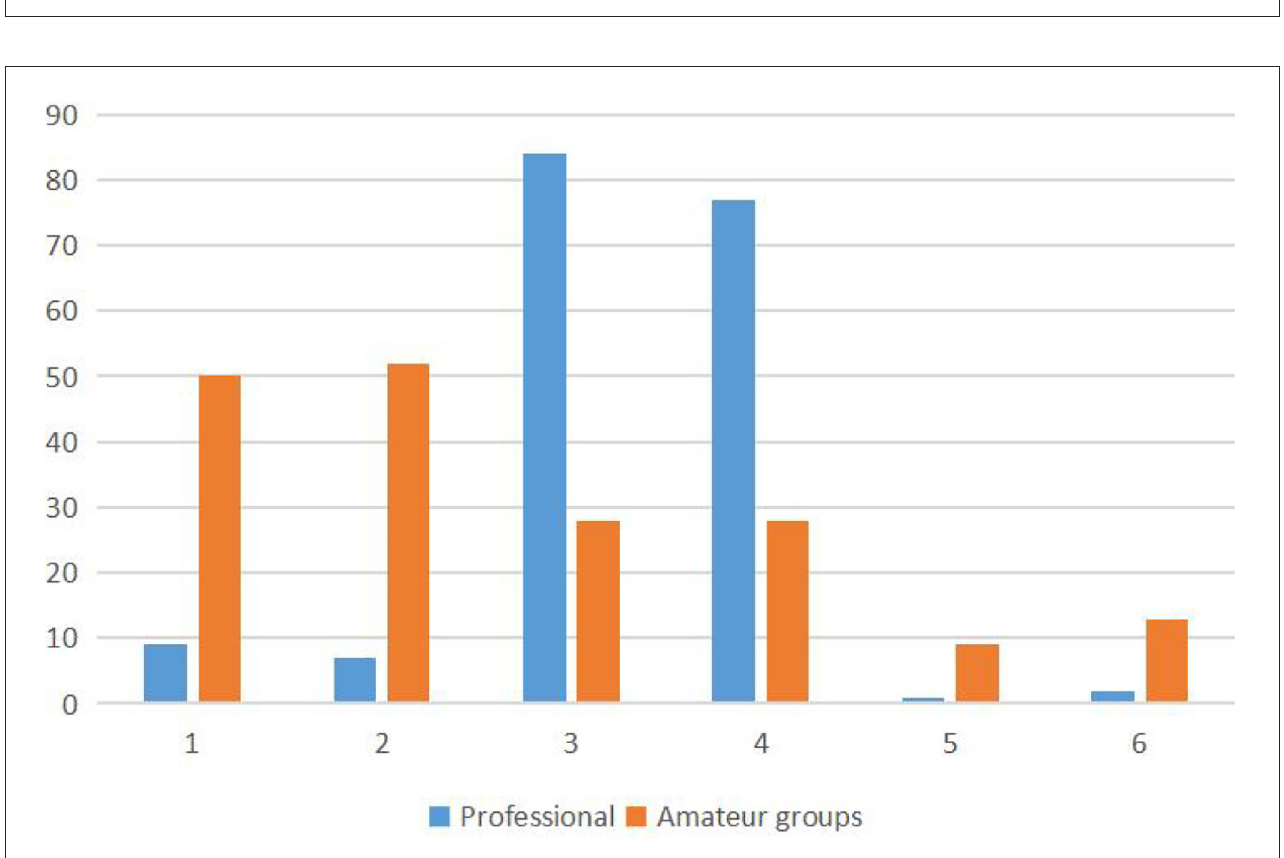
FIGURE5 The total fixation frequency of the different interest regions in the intuitionistic decision-making task of the two groups.